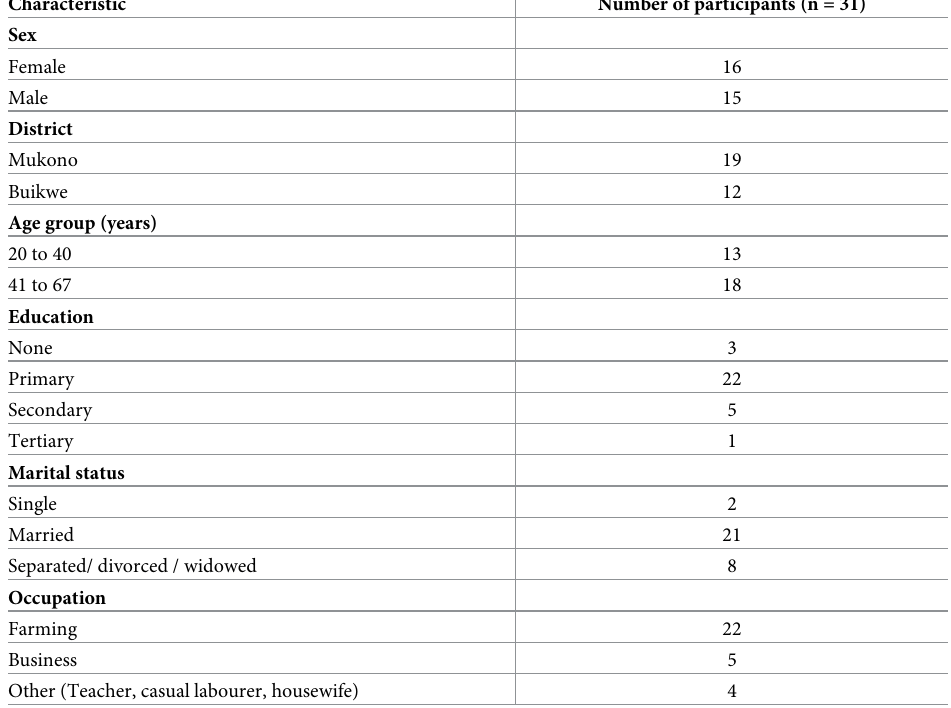
Table 1. Characteristics of study